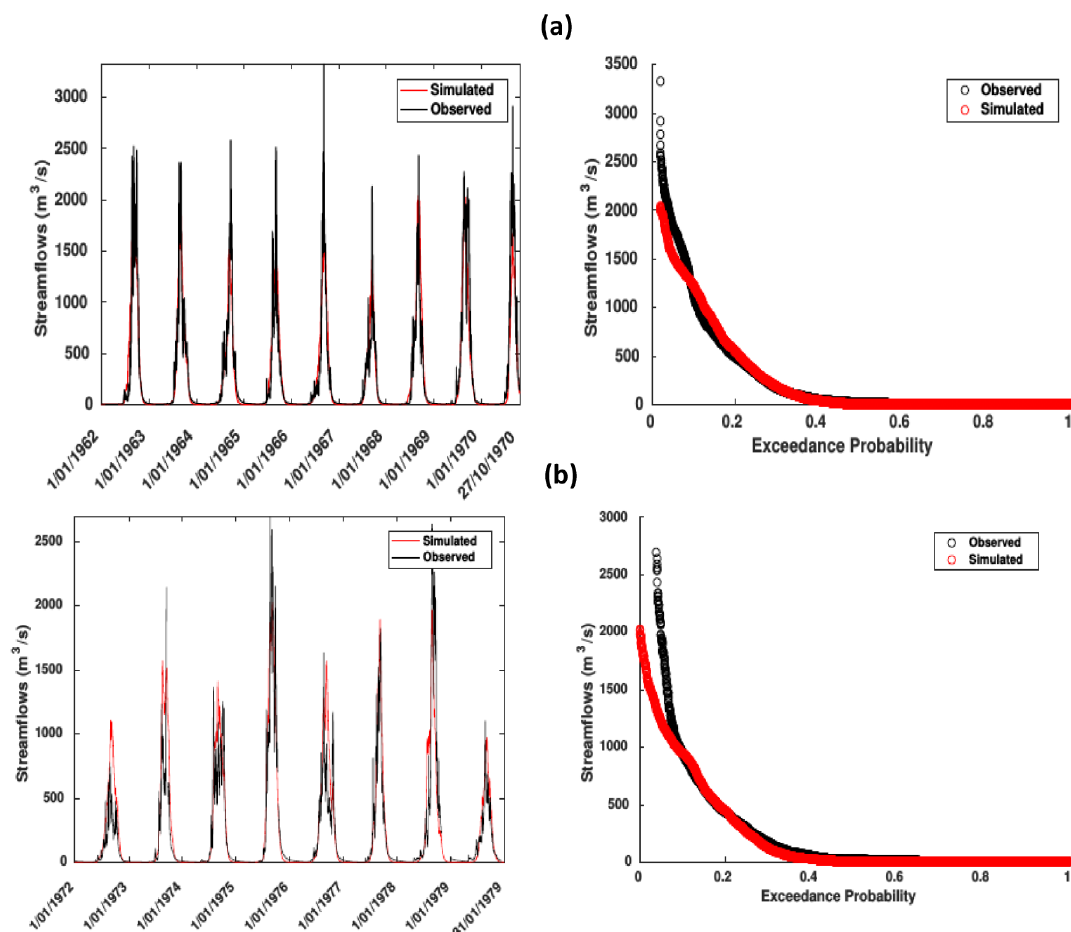
Figure 2. Comparison between observed and simulated hydrographs and flow duration curves at the Riao outlet during the calibration period (a) and validation period (b)